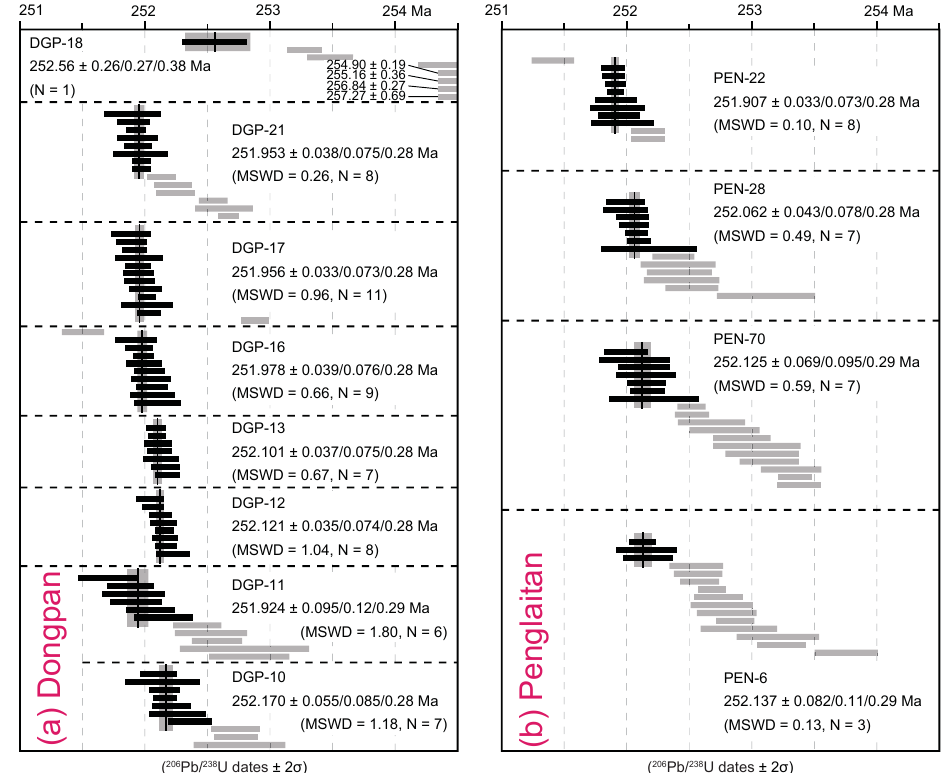
Figure 4. Single-grain zircon analysis and 206 Pb / 238 U weighted mean dates for (a) Dongpan and (b) Penglaitan volcanic ash beds and volcanogenic sandstones. U-Pb data of DGP-21, PEN-28 and PEN-22 are taken from Baresel et al. (2016). Each horizontal bar represents a single zircon grain analysis including its 2 σ analytical (internal) uncertainty, whereas grey bars are not included in the weighted mean calculation. Vertical lines represent the weighted mean age, with the associated 2 σ uncertainty (in grey). Uncertainty in the weighted mean dates is reported as 2 σ internal, 2 σ external uncertainty including tracer calibration and 2 σ external uncertainty including 238 U decay constant uncertainty; MSWD – mean square of weighted